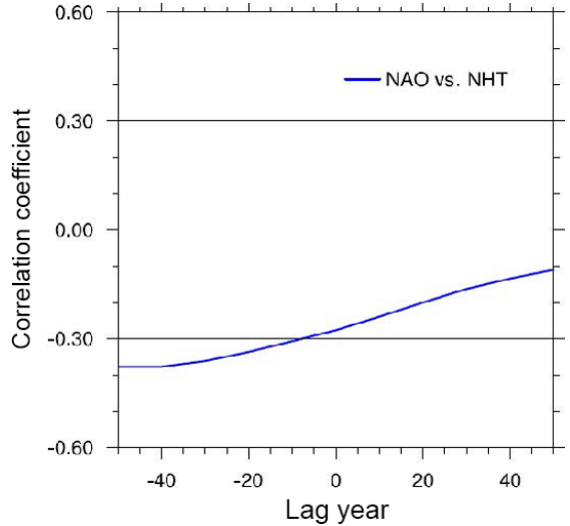
Figure 8. Lead–lag correlation between the annual mean North At- lantic Oscillation (NAO) and the Northern Hemisphere surface tem- perature (NHT) during 4.4–4.0ka derived from the TraCE-ALL run. The black lines ( ± 0 . 3) show the significance levels ( p